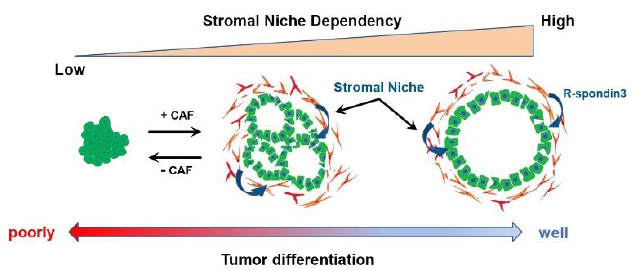
Figure 2. The relationship between the tumor differentiation grade and the dependency on stromal factors derived from CAFs in PDAC.